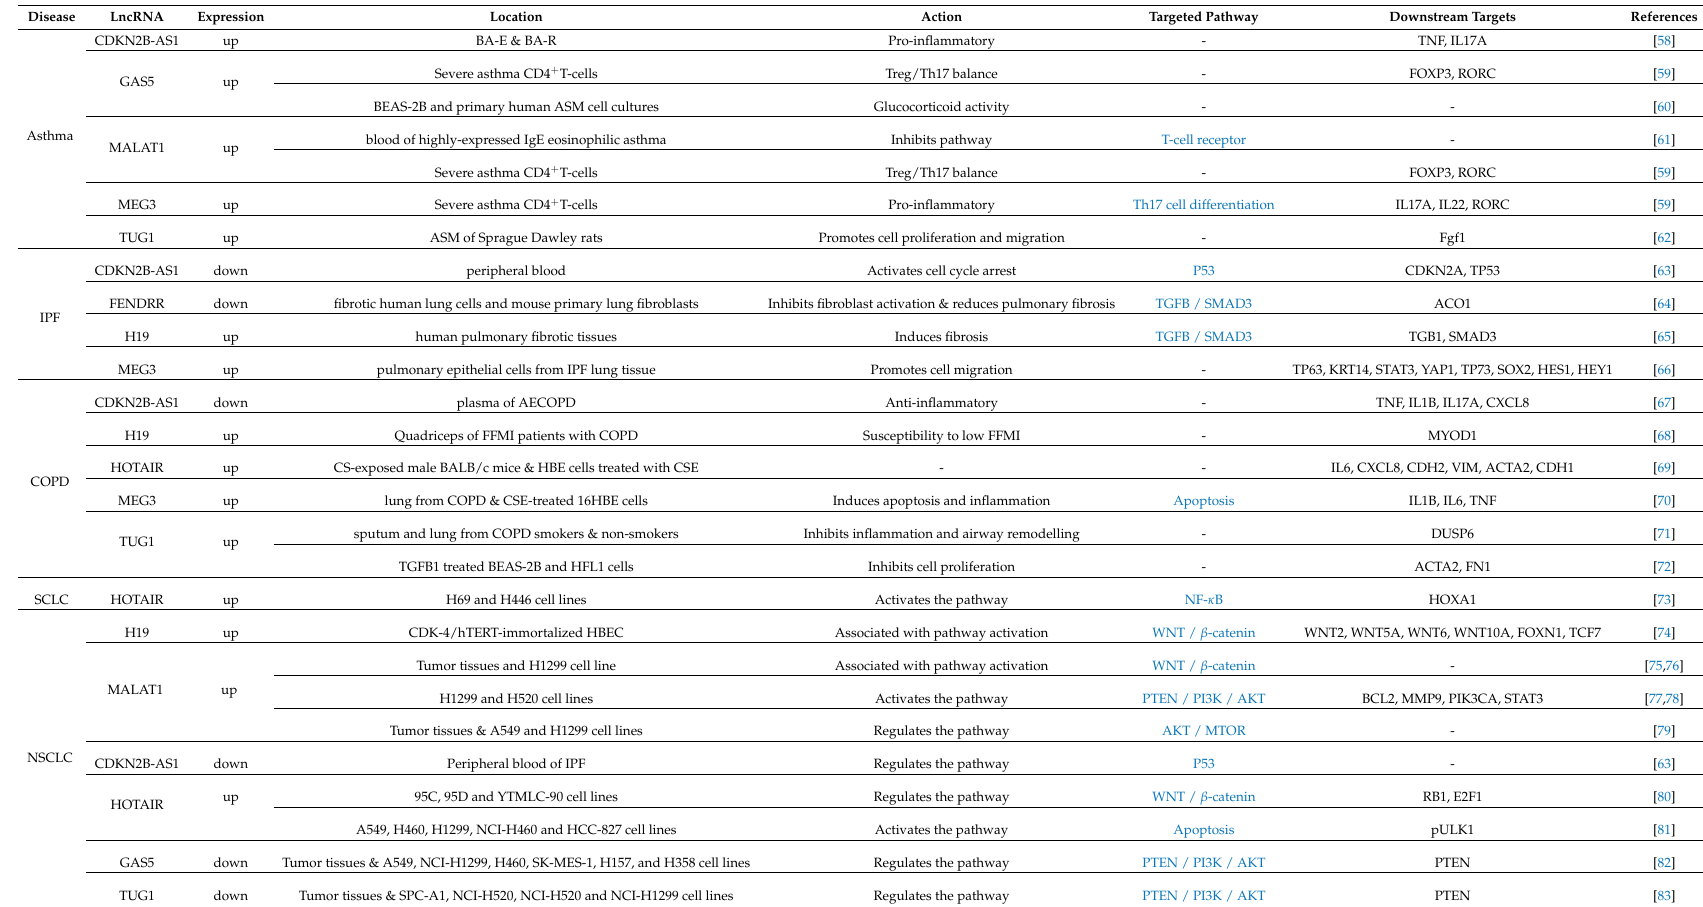
Table 1. Downstream targets of the 8 lncRNAs described in lung